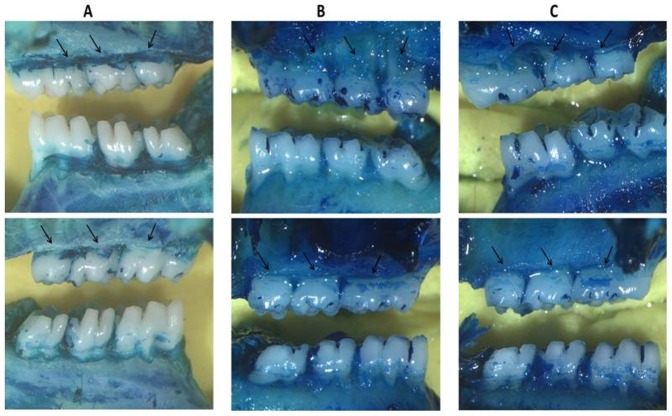
A) Superior: Left/Below: Right, NL group, showing no resorption of the alveolar bone.B) Superior: Left/Below: Right, L group, showing severe bone resorption with root exposure (arrows). C) Superior: Left/Below: Right, L group treated with Azilsartan 5 mg/kg, showing decreased bone resorption (arrows). Images were obtained at an original magnification of 1.7×.